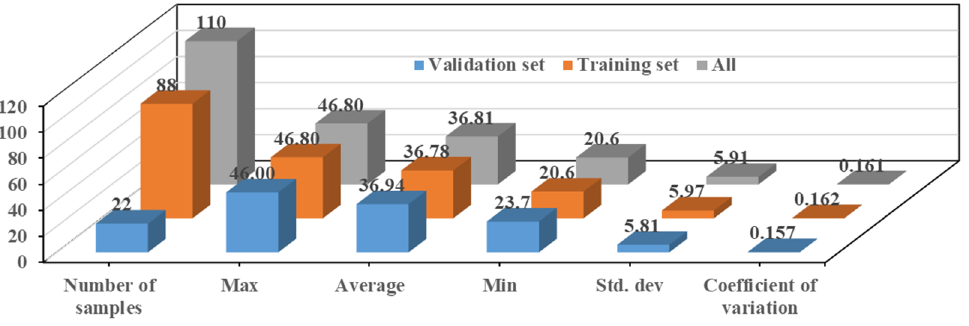
Figure 10. The statistics characteristics of dataset.